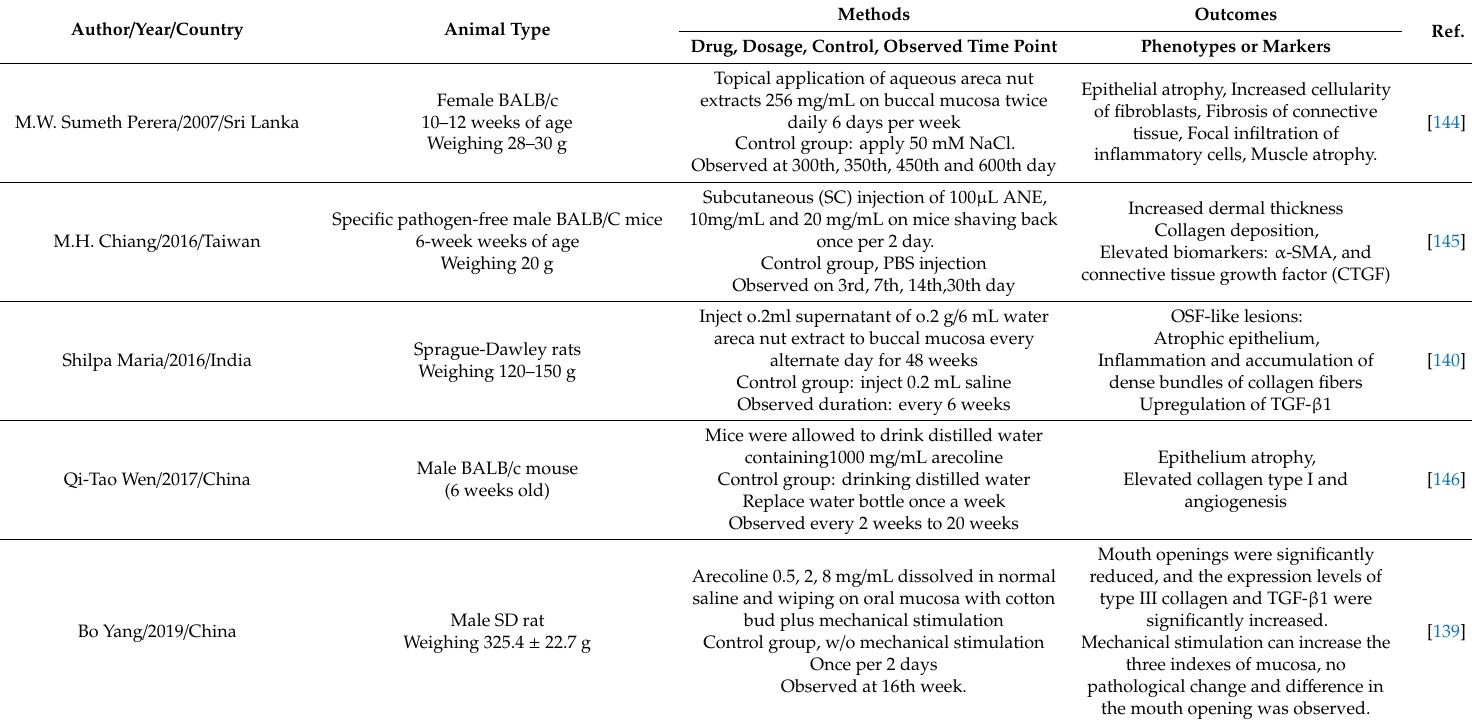
Table 4. Summary of the arecoline-induced OSF animal